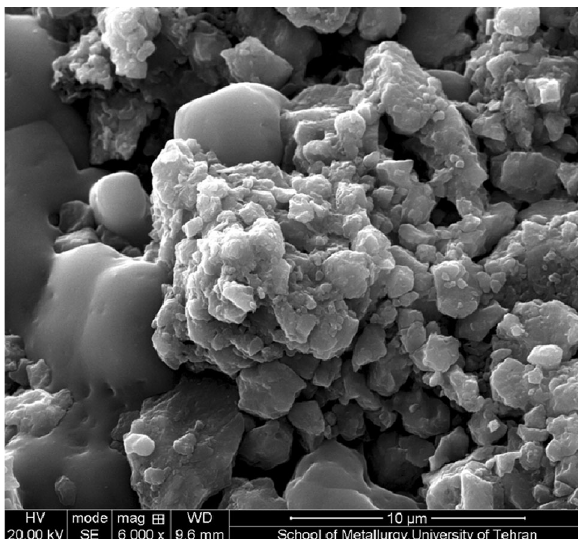
Fig. 7 Crystals of NaCl due to water injection